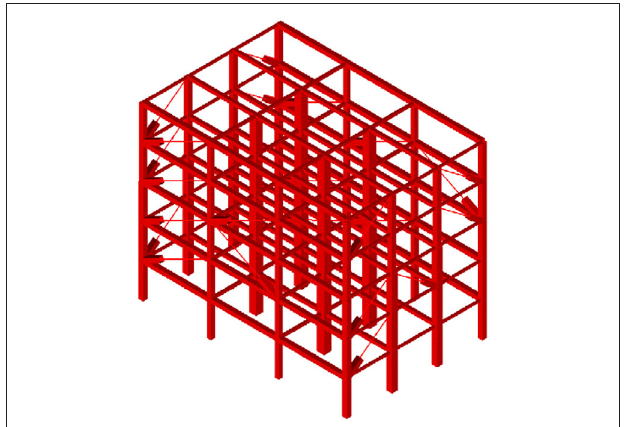
FIGURE 8 | New Configuration 1—the fourth generation solutions 3D ANSYS model.